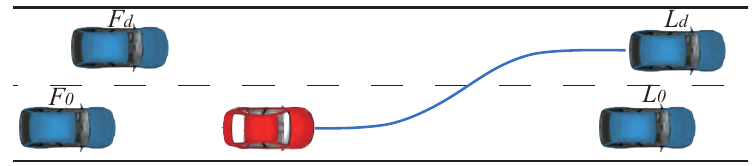
Figure 5. A lane-change scenario in double-lane highway.